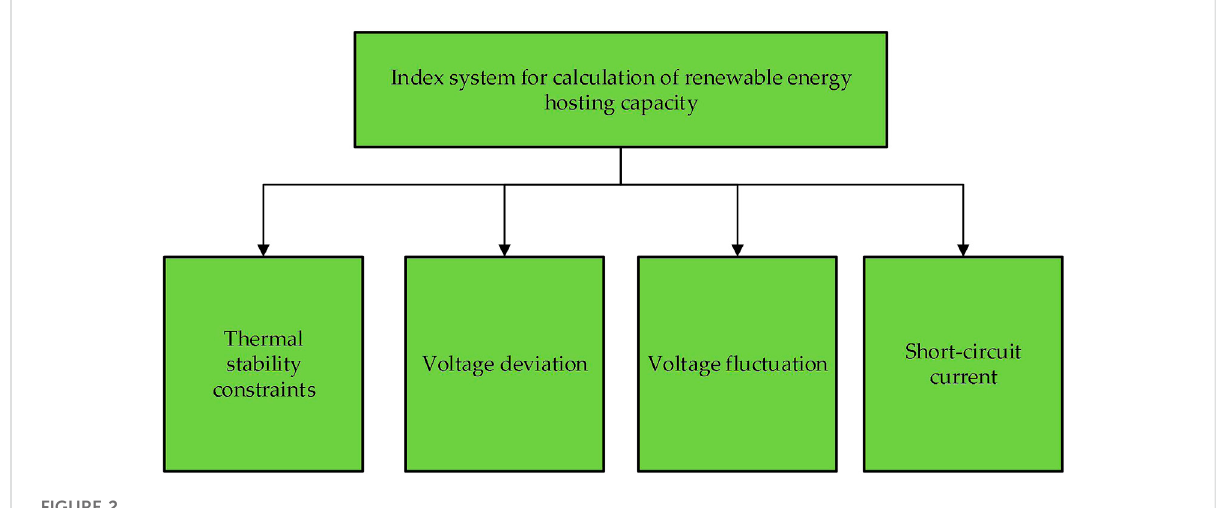
FIGURE 2 Index system for calculation of renewable energy hosting